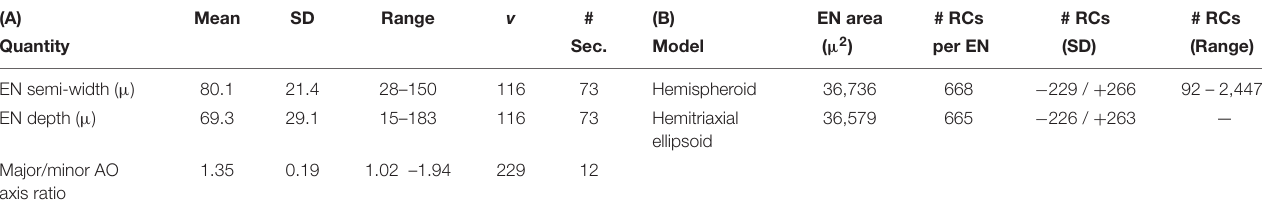
TABLE 3 | Estimates of receptor cell quantity.